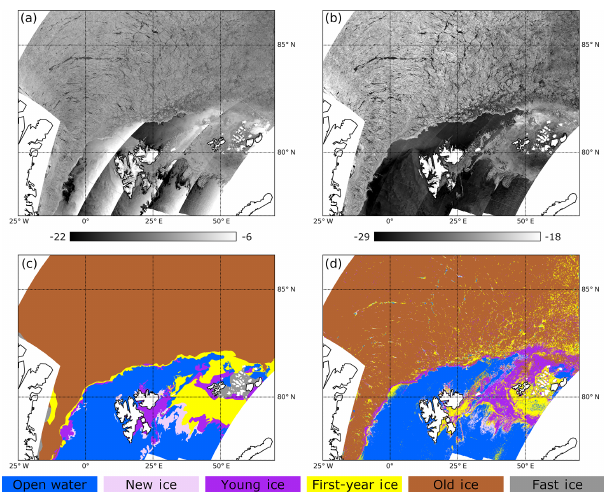
Figure 8. The 1d mosaics of Sentinel-1A/1B images ( a : HH; b : HV) and the ice classification result (d) on 8 February 2019. The publication date of the reference weekly ice chart (c) is 8 Febru- ary